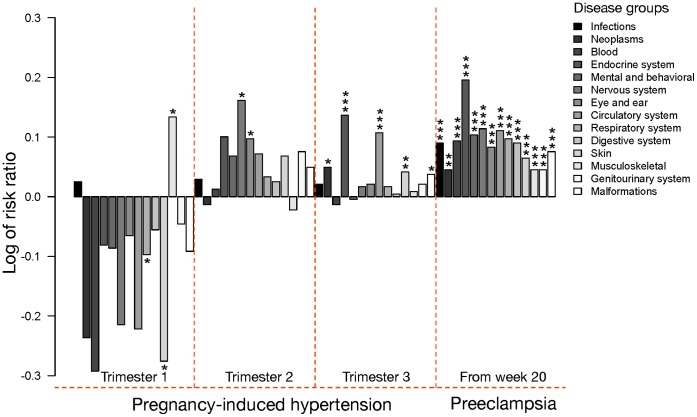
Risk of being diagnosed with a disease belonging to one of the 14 disease groups for offspring born to mothers with pregnancy-induced hypertension (PIH) in trimester 1, 2 or 3, or preeclampsia from week 20 onwards.Risk ratios and P values (*P<0.05, **P<0.01, ***P<0.001) come from Cox regressions and are relative to women with normotensive pregnancies (controls). Logged risk ratios represent increased (above 0) or decreased (below 0) risk of being diagnosed with disease across the ages of 1–27 years. The fourteen disease groups are listed towards the upper right with the same shading as in the bar plots. The plot is based on numbers provided in Table S1.